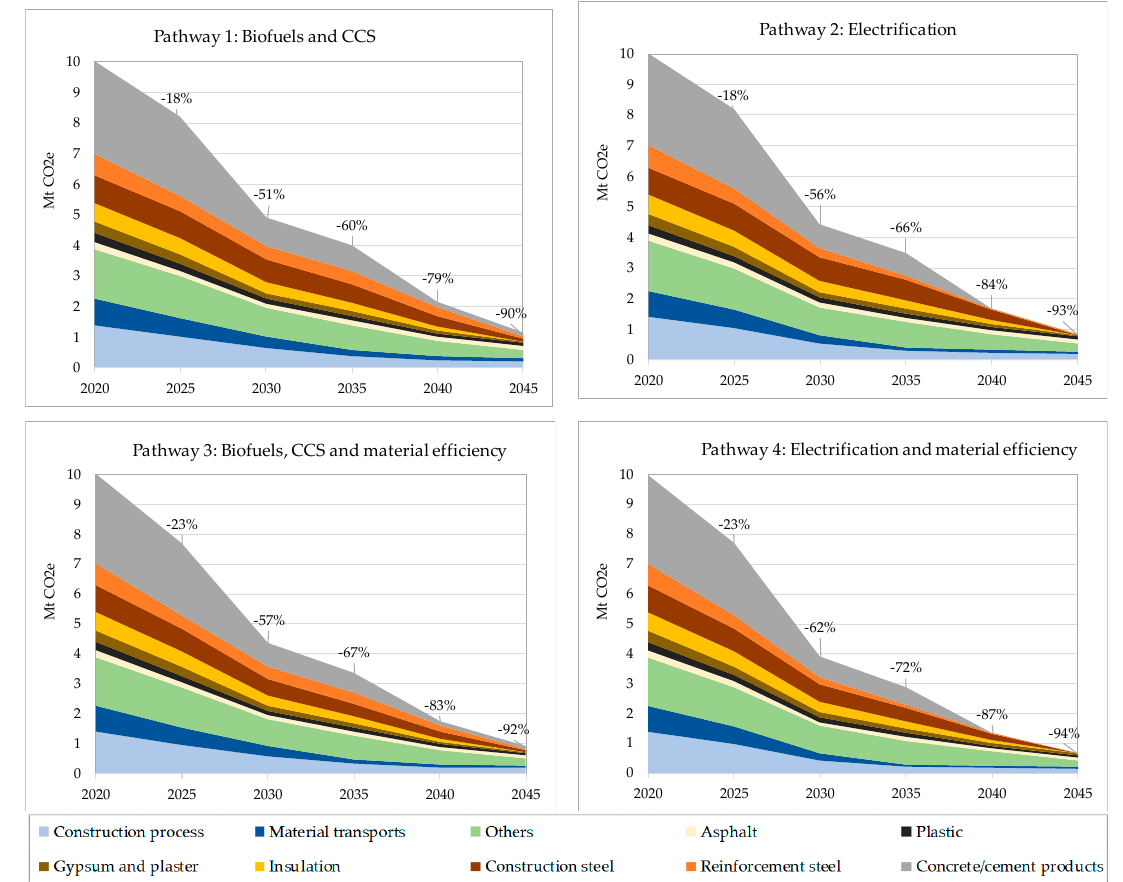
Figure 8. Results on CO 2 emissions for the buildings and transport infrastructure pathways from 2020 to 2045.